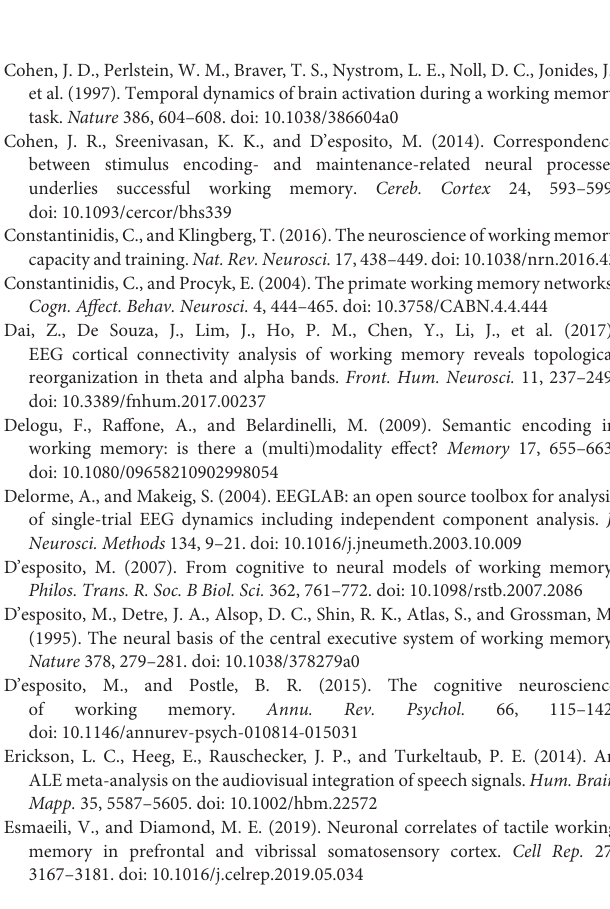
Supplementary Figure 1 | Comparisons of event related potential (EPR) components between the three conditions (A, V, and AV). The amplitude of N1 (100-160ms) and P2 (170-230ms) components did not differ between the conditions (p >0.136 for all). Supplementary Table 1 | Regression parameters form models predicting the amplitudes of N1 and P2 with theta